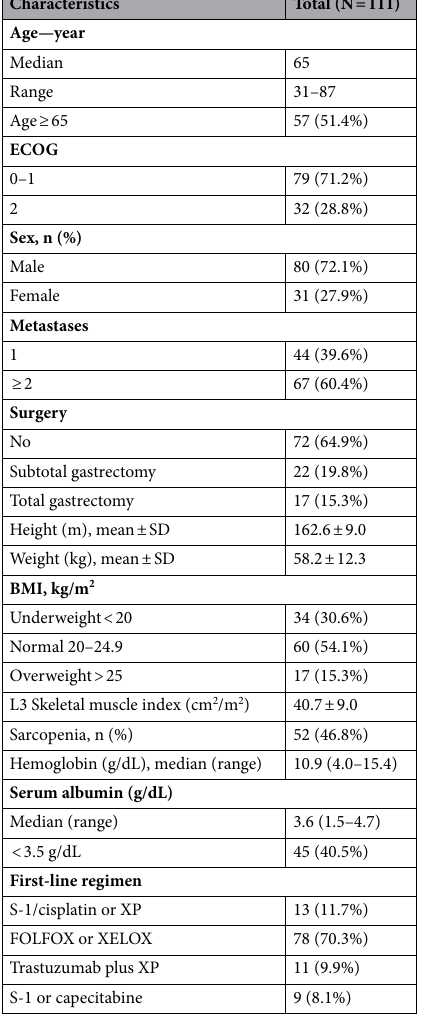
Table 1. Baseline characteristics. Sarcopenia was defined as an L3 skeletal muscle index of < 49 cm 2 /m 2 for men and < 31 cm 2 /m 2 for women using Korean-specific cutoffs. SMI skeletal muscle index, ECOG Eastern Cooperative Oncology Group, BMI body mass index, FOLFOX 5-fluorouracil, leucovorin, and oxaliplatin, XELOX capecitabine and oxaliplatin, XP capecitabine and cisplatin, ORR overall response